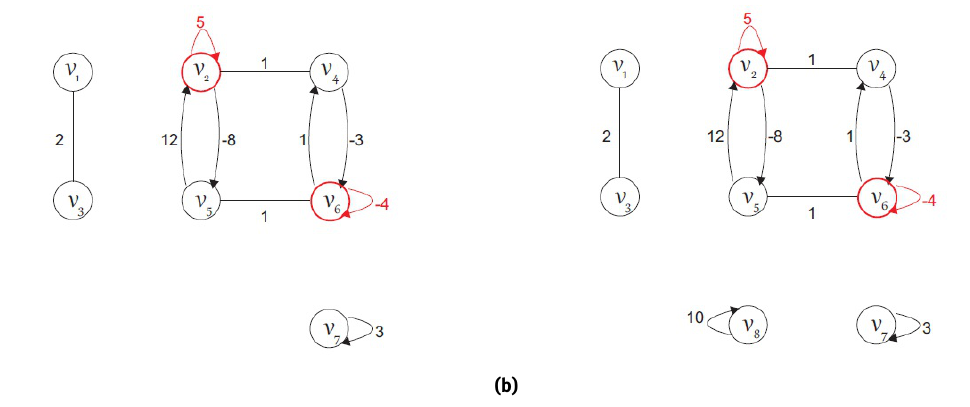
Figure 2: Example of a B -partition of (a) Digraph of matrix M 1 (b) Digraph of matrix M